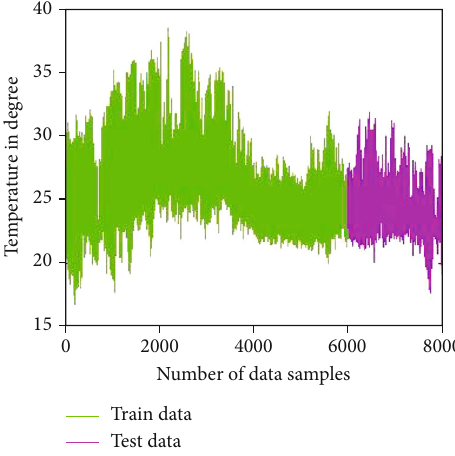
Figure 8: Data samples of the ambient temperature trained and tested dataset.